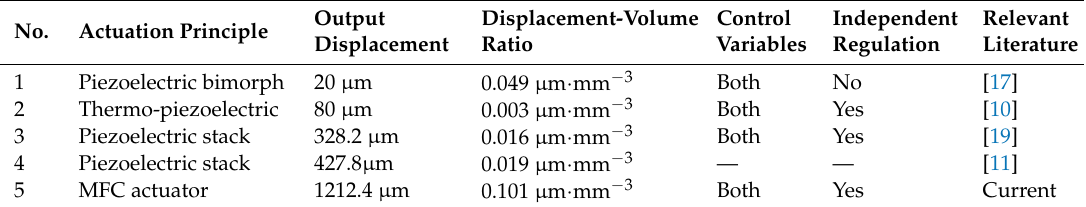
Table 2. Comparisons with reported piezoelectric